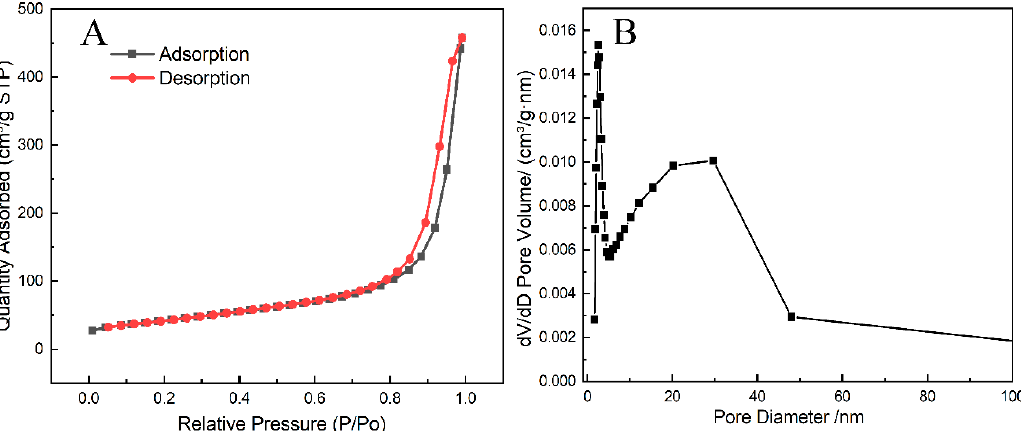
Figure 2. Nitrogen (N 2 ) adsorption–desorption isotherms of MoS 2 /MWCNT-COOH hybrid ( A ), Barret–Joyner–Halenda (BJH) adsorption dV/dD pore volume of MoS 2 /MWCNT-COOH hybrid ( B ).